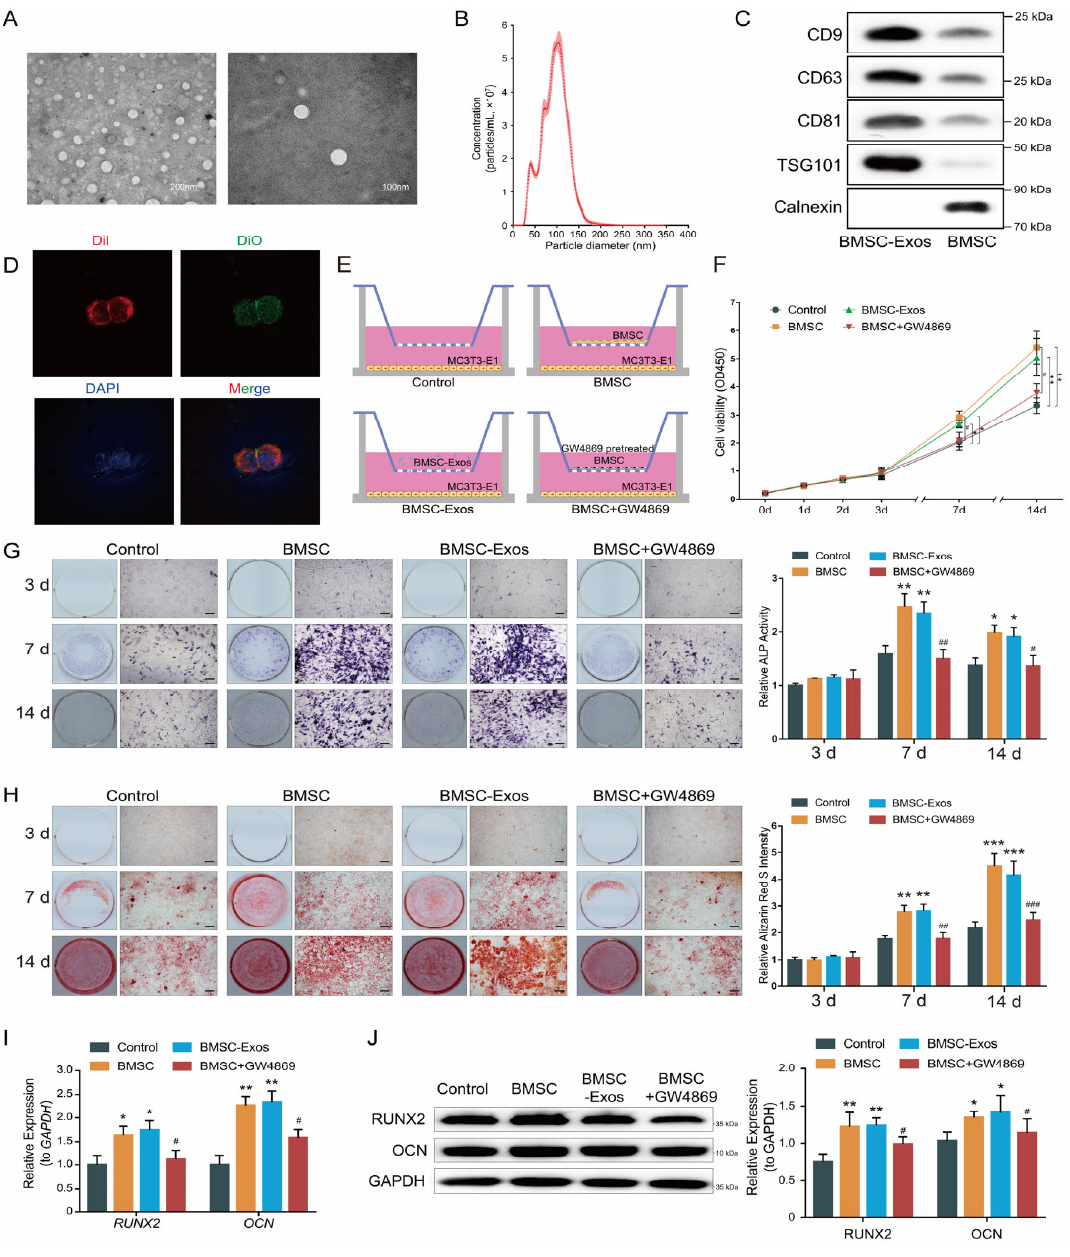
Figure 1. BMSC-Exos promoted osteogenesis. ( A ) Representative picture of BMSC-Exos collected by ultracentrifugation. ( B ) Size distribution profile of BMSC-Exos ( n = 3). The dots represent the mean value, and the shading represents the SD. ( C ) Western blot analysis of exosome-specific markers (CD9, CD63, CD81 and TSG101) and negative marker (Calnexin). ( D ) Intercellular trafficking of BMSC-Exos. Cytomembranes were labeled by Dil (red); BMSC-Exos were labeled by DiO (Green); nuclei were labeled by DAPI (blue). ( E ) Schematic drawing of the Transwell protocol. ( F ) Cell proliferation assays. Each point represents the mean value from three independent samples. * p < 0.05; ** p < 0.01. ( G ) ALP staining (left) was examined and activity of ALP (right, n = 6) was analyzed by ALP activity assay kit. Bar 100 µ m. ( H ) ARS staining was performed (left) and quantified using a microplate reader at 562 nm (right, n = 6). Bar: 100 µ m. ( I ) Fold changes in the expression of RUNX2 and OCN in MC3T3-E1 cells relative to GAPDH ( n = 6). ( J ) Western blot analysis (left) and quantification of Western blot results (right, n = 3). * p < 0.05, ** p < 0.01, *** p < 0.001 vs. the control group; # p < 0.05, ## p < 0.01, ### p < 0.001 vs. the BMSC